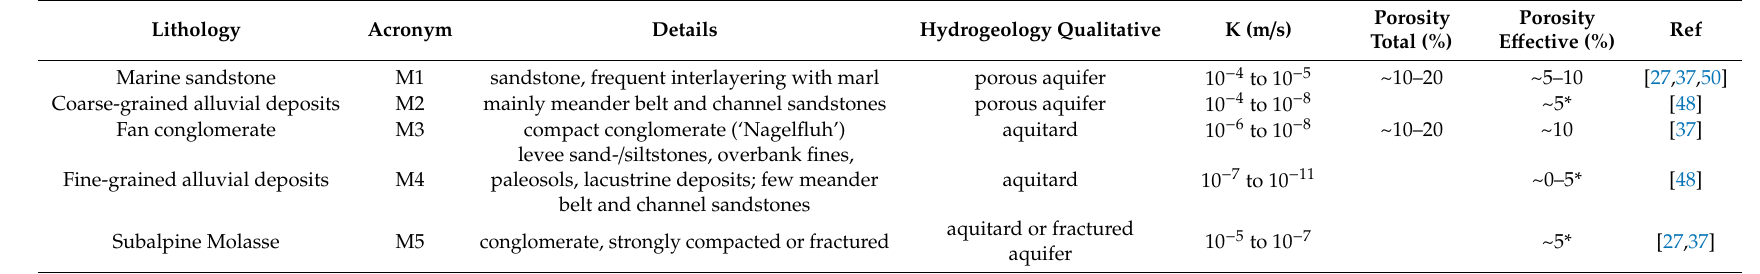
Table 1. Molasse lithologies with hydrogeological properties based on values from the literature.